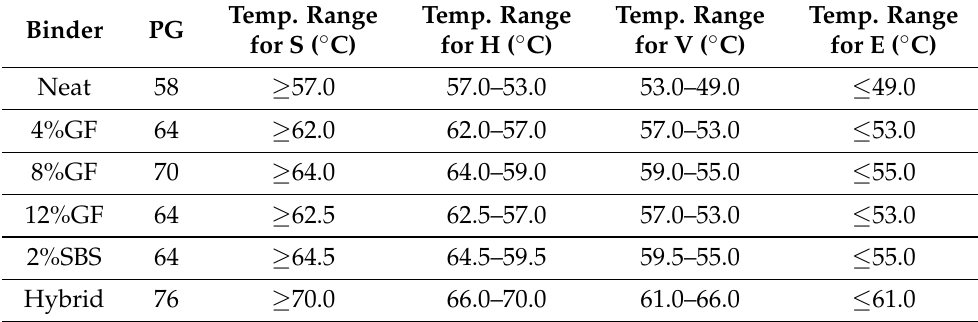
Table 11. Grading and traffic-level results of geopolymer, SBS, and hybrid asphalt binders.